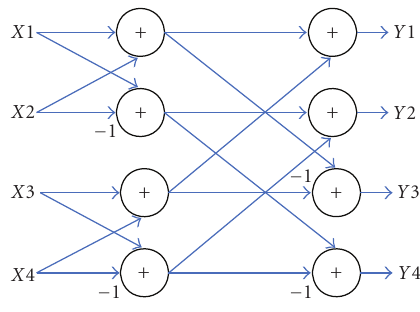
Figure 13: Four-point